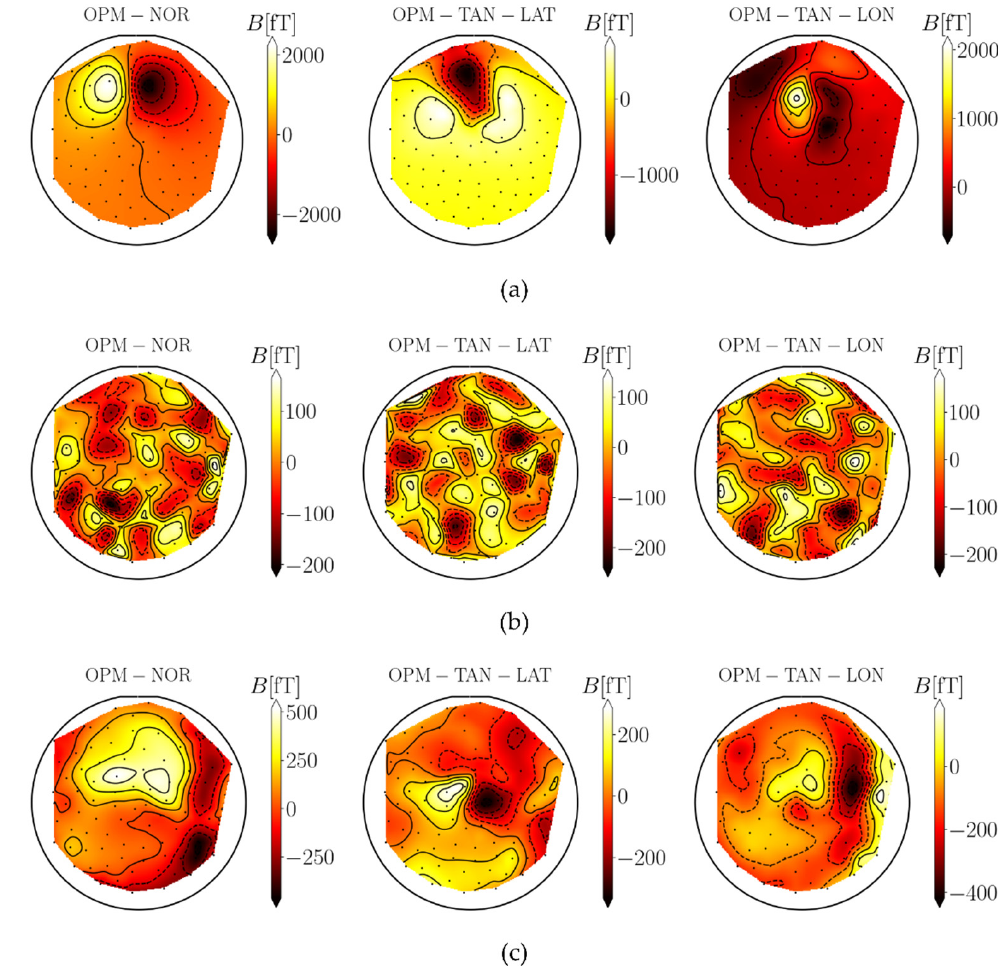
Figure 4. MFMs for one sample time frame for three cases: the simulated dipole without noise ( a ), simulated ambient noise ( b ), and spontaneous brain noise ( c ).